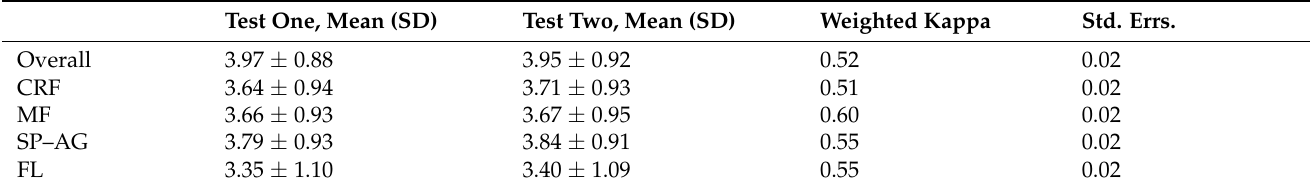
Table 1. Reliability of the International Fitness Scale.